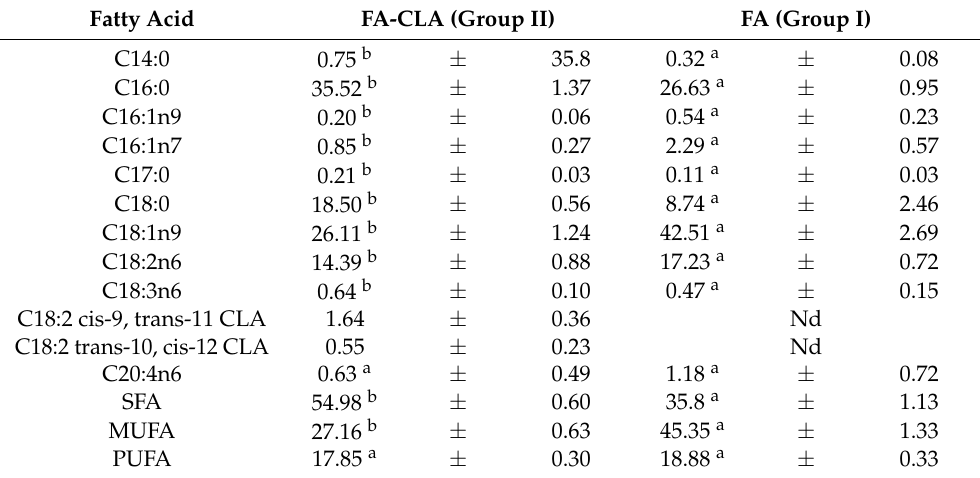
Table 1. Fatty acid profile of extracted chicken egg yolks enriched (FA-CLA) and non-enriched in CLA